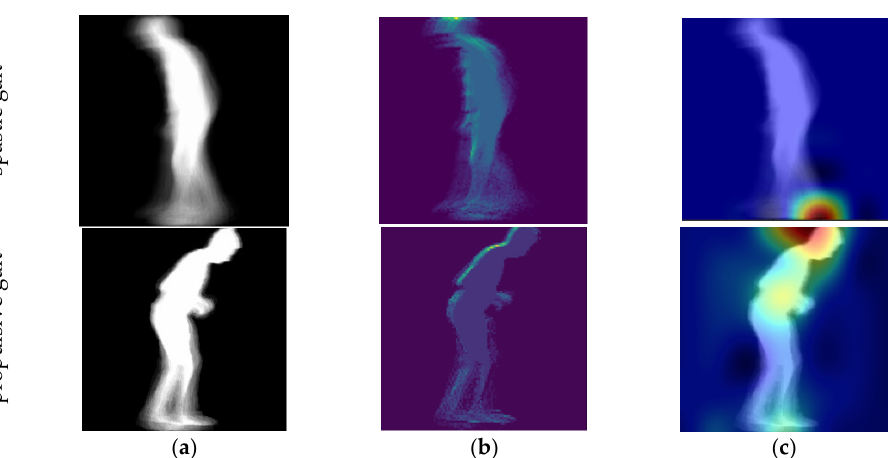
Figure 6. Output of the visualizer ( a ) GEI, ( b ) saliency feature map, ( c ) class activation map.